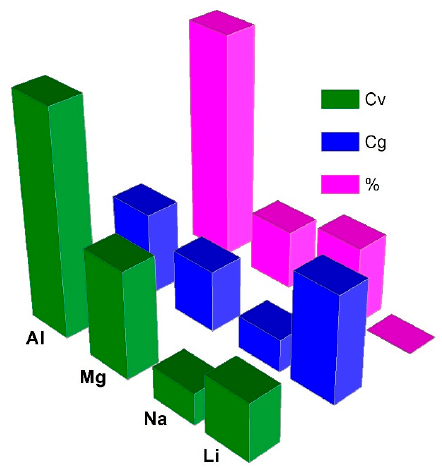
Figure 5. C v , C g and % abundance comparisons of Li, Na, Mg, and Al. Table 2. Comparison of C g and C v , standard redox potential (E o vs. SHE), ionic radius (r ion ), and abundance in the Earth’s crust of various metal anodes [67].